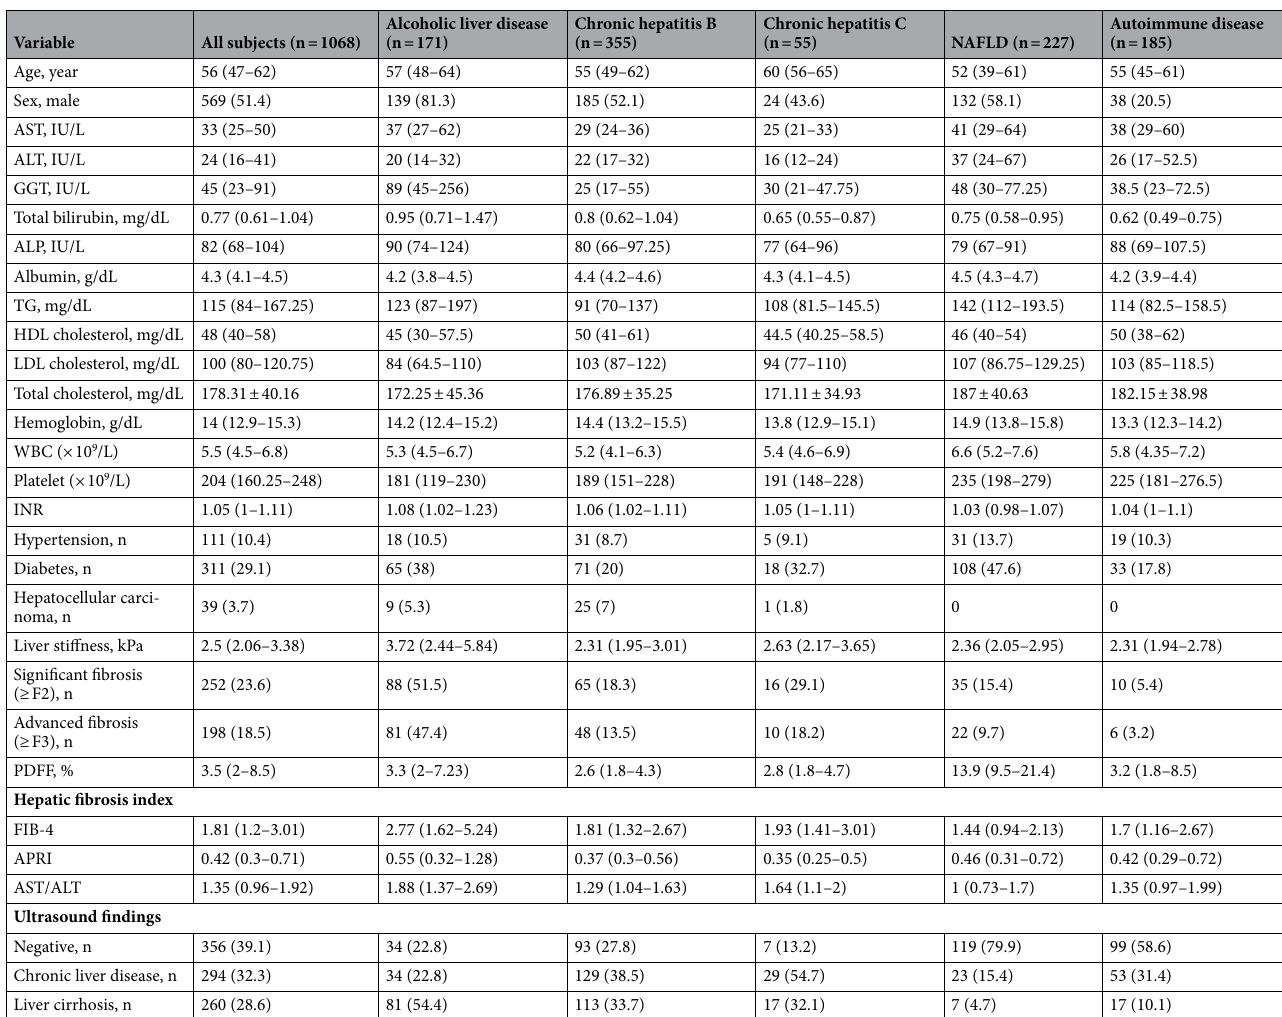
disease, AST aspartate aminotransferase, ALT alanine aminotransferase, GGT gamma-glutamyl transferase, ALP alkaline phosphatase, TG triglyceride, HDL high-density lipoprotein cholesterol, LDL